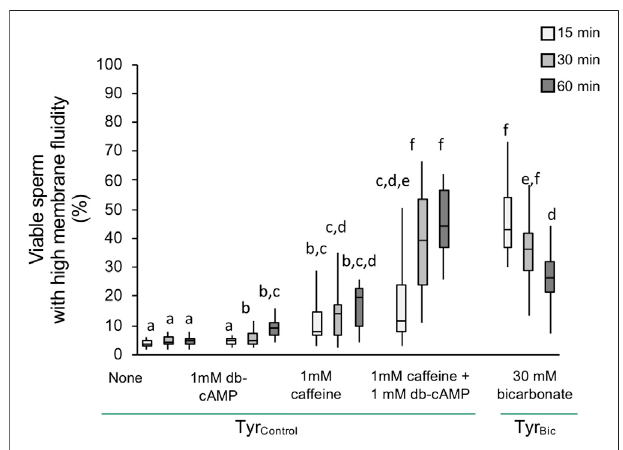
FIGURE 1 | An increase in plasma membrane fl uidity in viable stallion spermatozoa is dependent on cAMP signalling. Spermatozoa were in incubated in Tyrodes (Tyr) medium either in the presence of 30 mM bicarbonate (Tyr Bic ) or its absence (Tyr Control ). An increase in plasma membrane fl uidity, i.e. increased merocyanine540 staining, in viable (Hoechst 33258 negative) spermatozoa was induced by bicarbonate within 15 min. A similar, but delayed, increase was evoked by 1 mM caffeine and 1 mM bd- cAMP ( n (cid:2) 8 stallions; p <